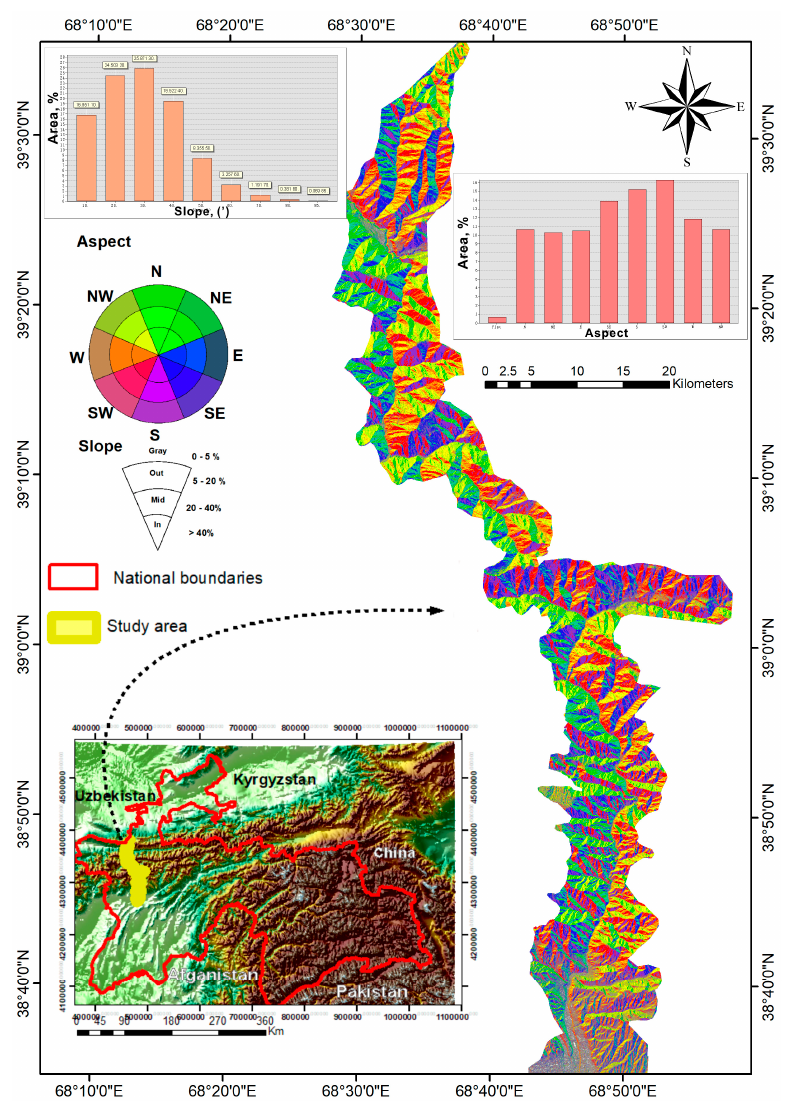
Figure 2. Aspect-slope map of the study area. The left histogram shows the area (y)-slope (x) distribution, and the right histogram shows the area (y)-aspect (x) distribution.